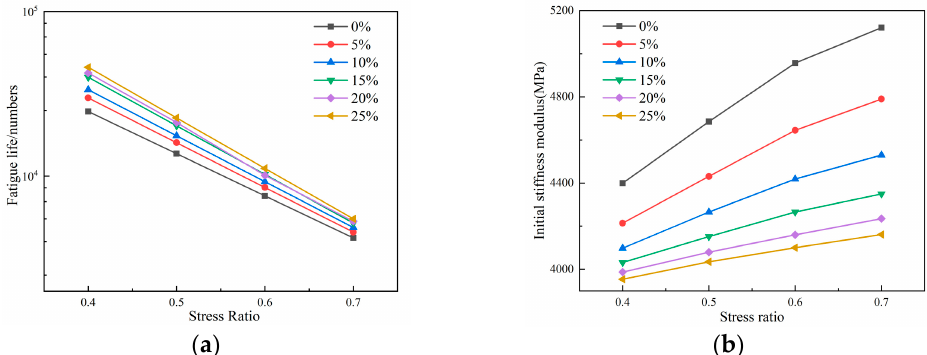
Figure 8. FBBF test results: ( a ) fatigue life numbers, and ( b ) initial stiffness modulus.